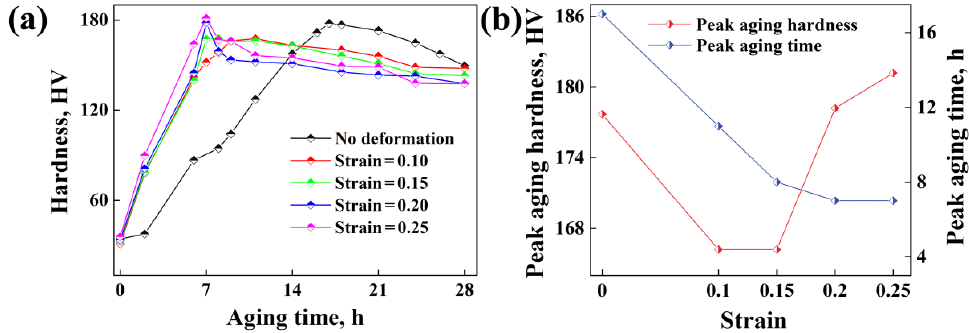
Figure 2. ( a ) Vickers hardness of samples with aging time under different strains; ( b ) peak aging hardness and peak aging time for samples with different strains.